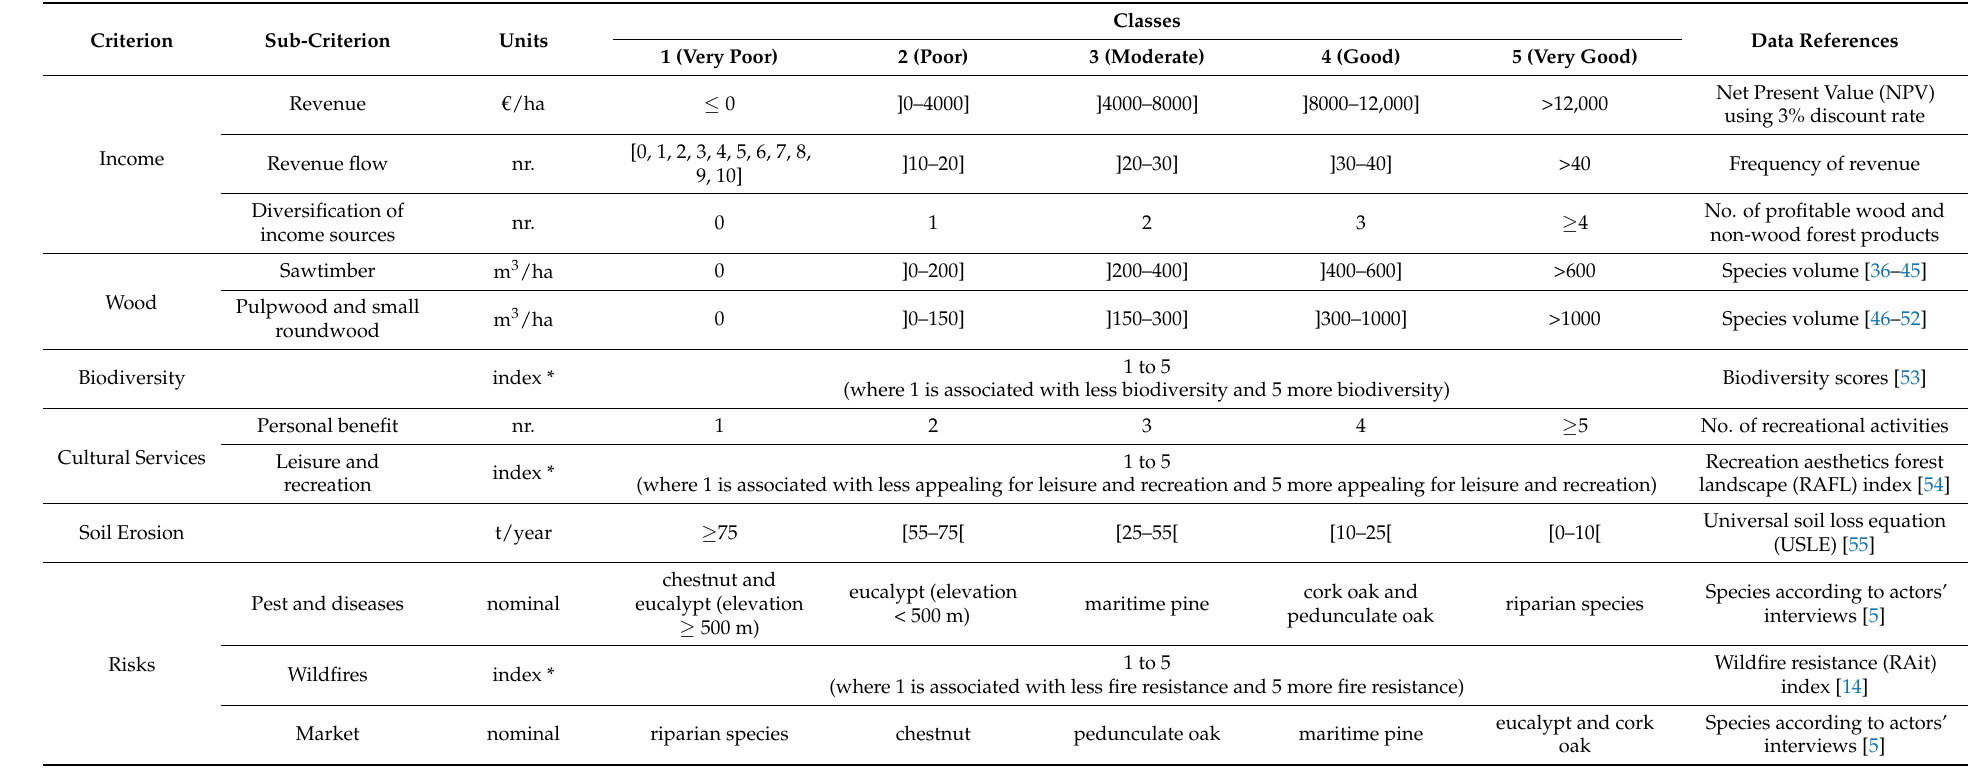
Table 3. Normalization of Pareto frontier database solutions into five classes for a 90-year planning horizon according to the lowest